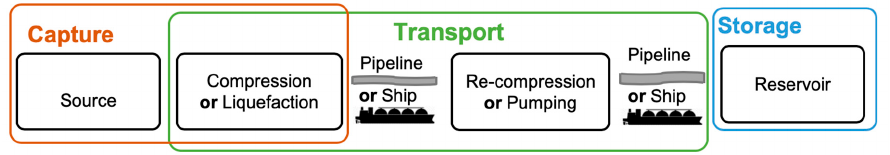
Figure 1. Simplified Illustration of a Typical CCS Value Chain.